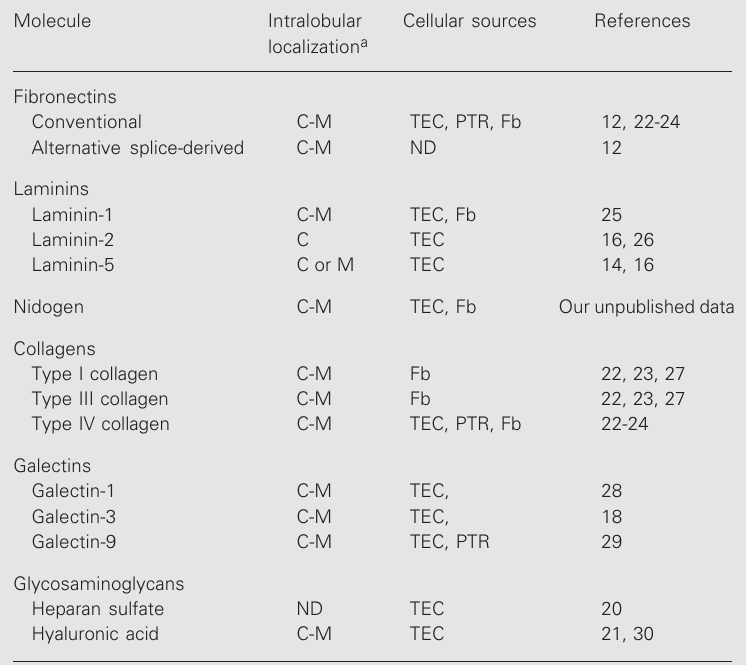
Figure 4. Intrathymic distribution of nidogen and of the molecule recognized by the ER-TR7 mono- clonal antibody. In these frozen sections of young adult mouse thymus, we can see in the upper panels immunoperoxidase as- says showing the presence of nidogen in the cortical (a) and medullary (b) regions of thymic lobules. Note that nidogen con- tent is higher in the medulla (M), compared to the cortex (C). The molecule recognized by the ER- TR7 monoclonal antibody is seen in the bottom panel (c), and its co-localization with laminin is well known (d), as indicated by the arrows. Original magnifica- tion: 250X.